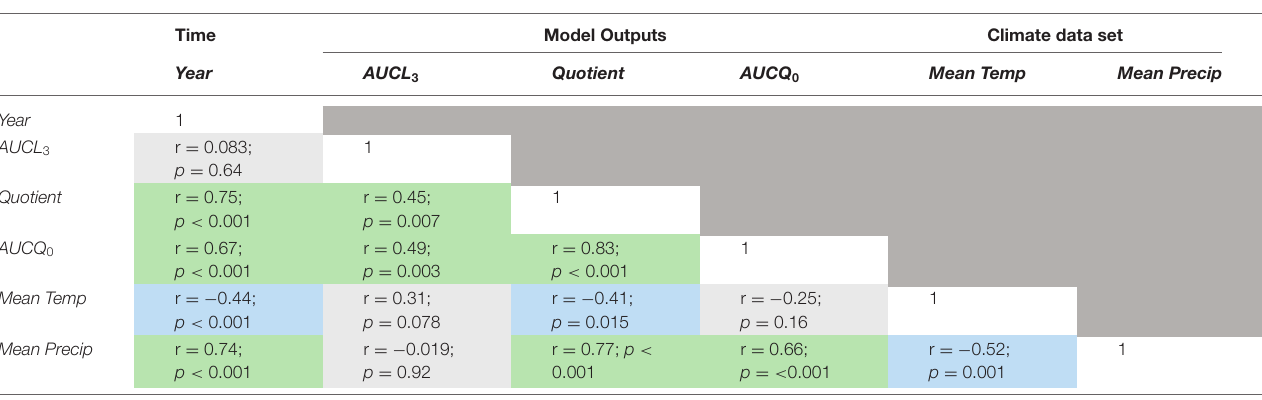
TABLE 5 | Correlation matrix between climate data set and model outputs for the years 1985–2018.